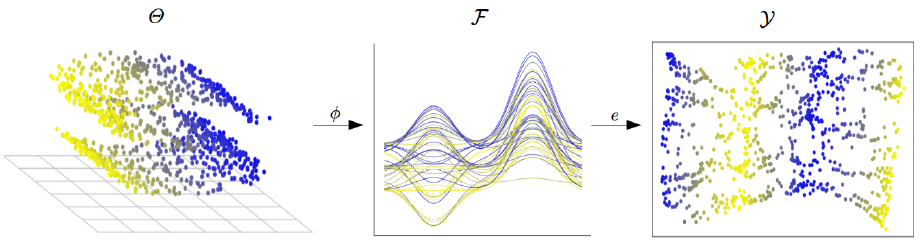
Figure 2. Functional data from a manifold-learning perspective. Image source: Herrmann